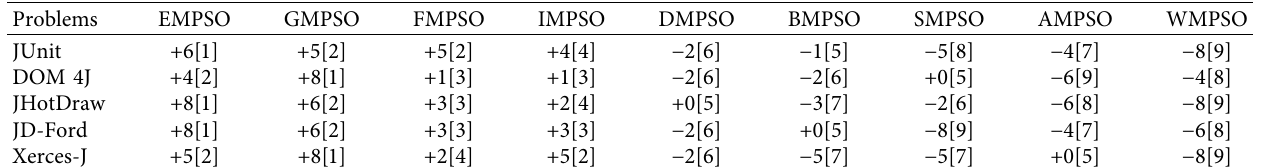
Table 4: Difference [rank] values of each variant in terms of the MQ.